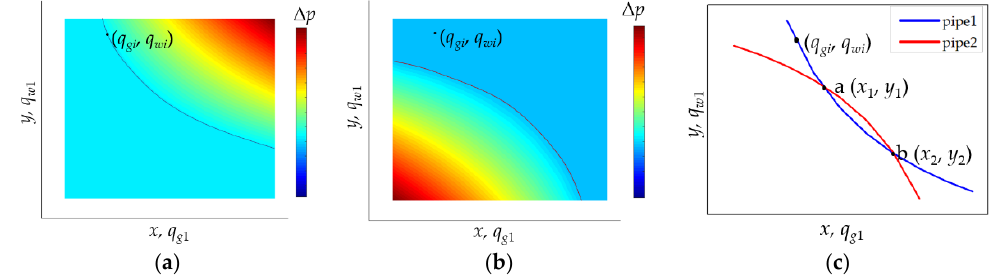
Figure 5. Obtaining the reasonable flow rate pairs by intersecting the two intersection lines: ( a ) the x − y plane view of the possible ‐ value lines of the first pipe; ( b ) the x − y plane view of the possible ‐ value lines of the second pipe; ( c ) the reasonable flow rate pairs.